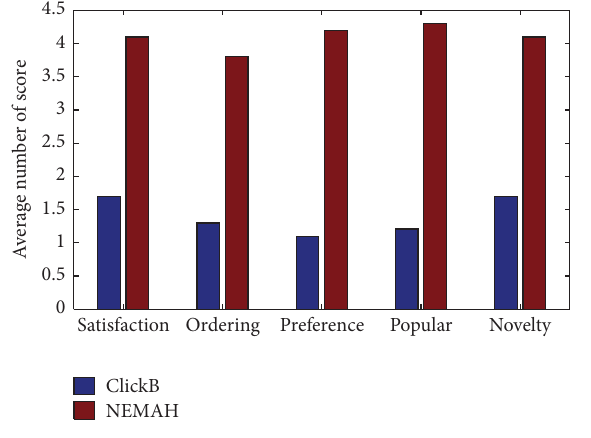
Figure 11: User study on different